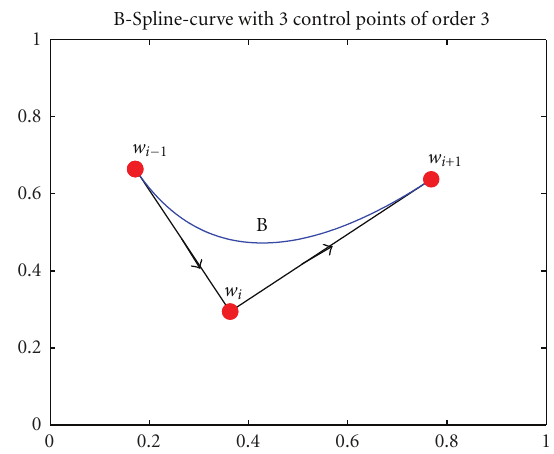
Figure 3: A quadratic ( p = 2) 2-dimensional B-Spline curve, produced using a uniform nonperiodic knot vector, and its control